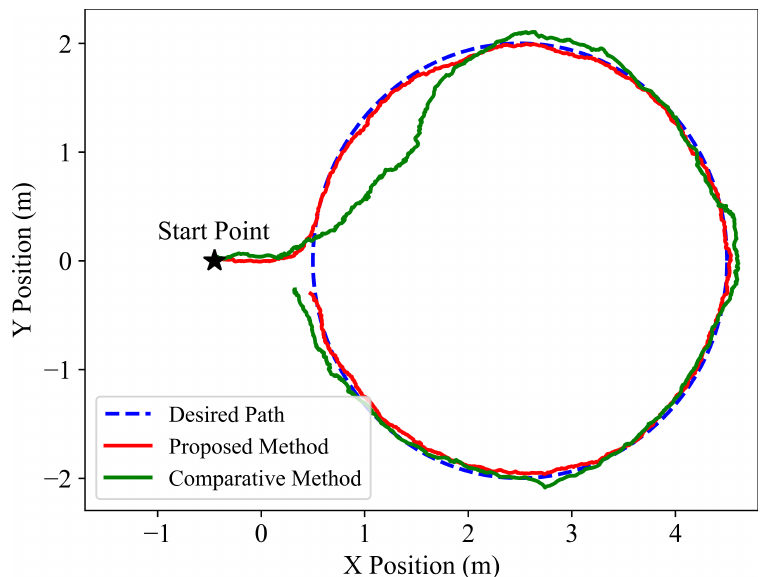
Figure 5. Simulation path following results of the desired circle for the proposed hierarchical method and the end-to-end comparative